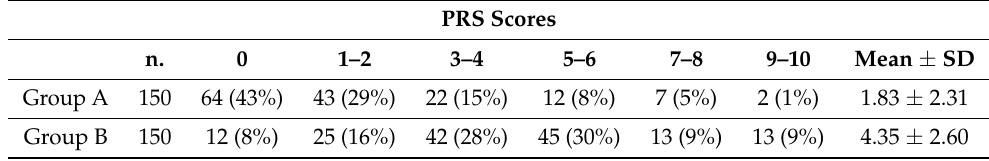
Table 1. Distribution of the PRS scale pain